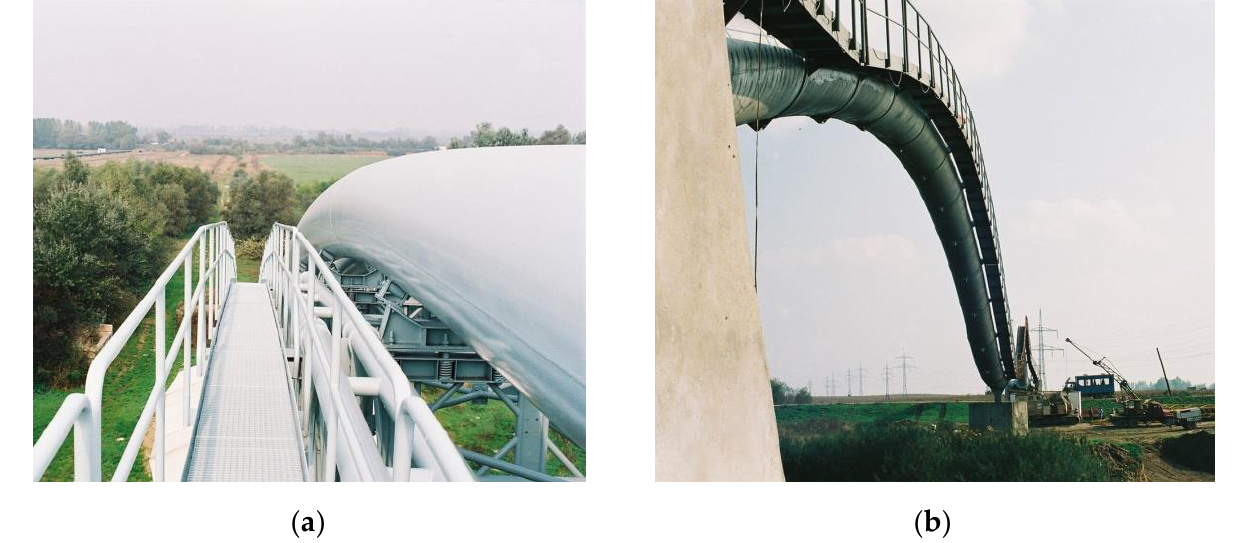
Figure 3. ( a ) Truss three-jointed arch; ( b ) Self-supporting pipe.